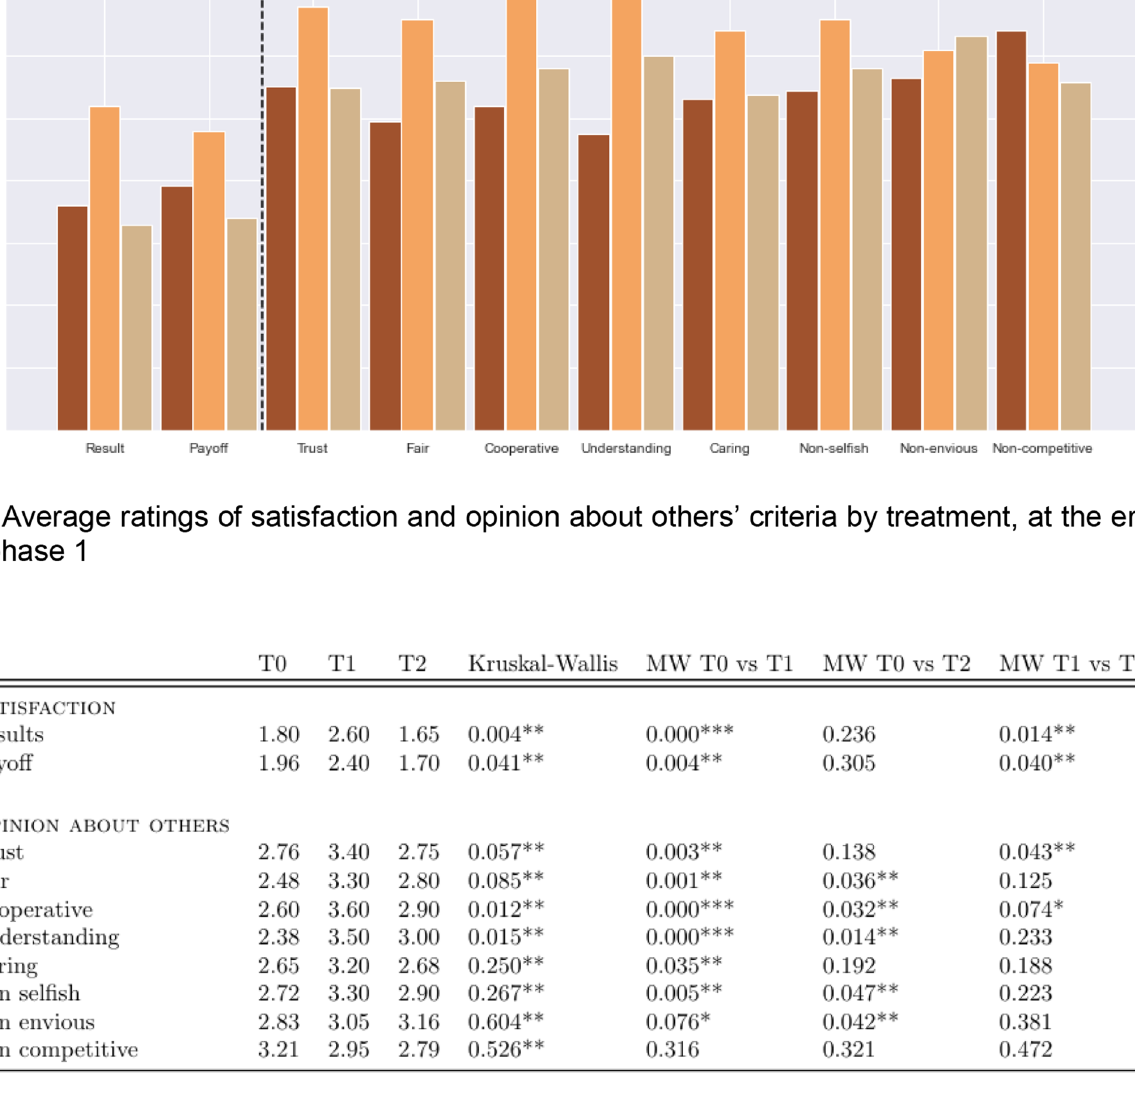
Figure 2. Average ratings of satisfaction and opinion about others’ criteria by treatment, and non-parametric statistical